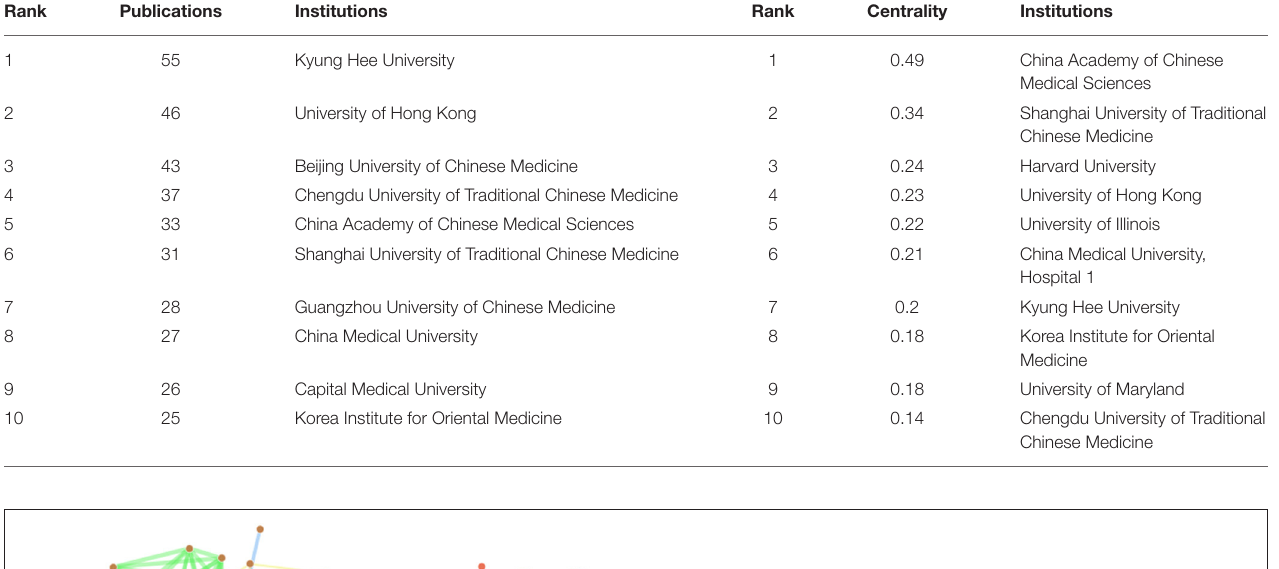
TABLE 4 | Top 10 publications and centrality of institutions related to acupuncture on depression. Rank Publications